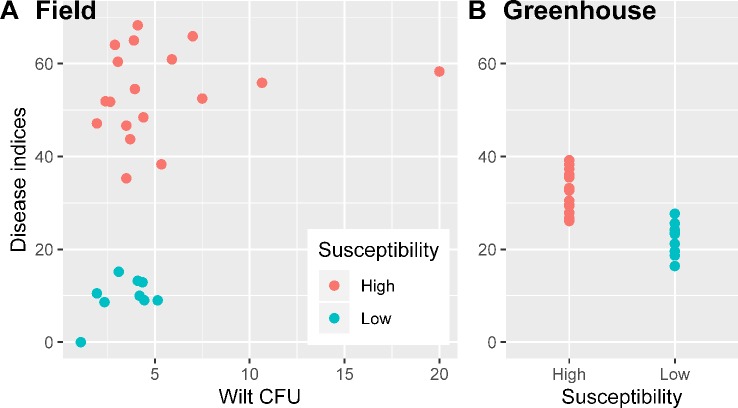
Wilt inoculum CFU values and disease indices for nine cotton cultivars in the field experiment were the averages over three replicates plots (A); wilt disease indices of the greenhouse inoculation trials in sterilized soils (inoculated Verticillium dahliae) were summarized over three replicates experiments (B).